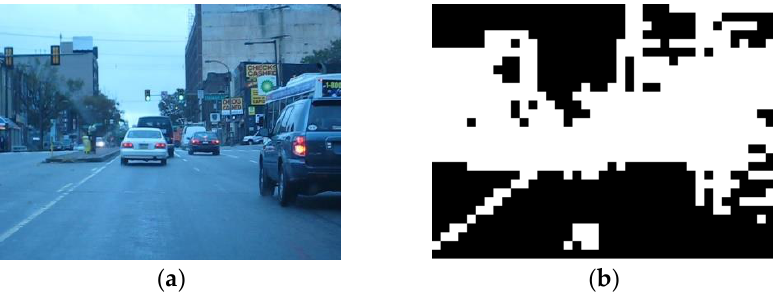
Figure 6. Sample of foreground detection result: ( a ) Sample frame; ( b ) Foreground detection result of sample frame.